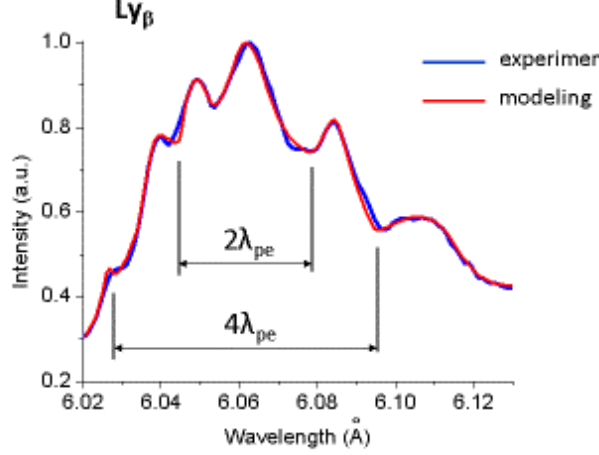
Figure 4. Experimental spectrum of Al XIII Ly β and its comparison with the Stark broadening code including L-dips and the spectral line broadening by LET. The experimental spectrum was obtained in a single laser shot with initial laser intensity at the surface of the target estimated as 6.7 × 10 20 W/cm 2 . The positions of the L-dips in the profiles (the L-dips being very pronounced) are marked by vertical lines separated either by 2 λ pe or 4 λ pe , where λ pe = [ λ 02 /(2 π c )] ω pe ( λ 0 is the unperturbed wavelength of the corresponding line). Also shown is a theoretical profile at N e = 2.35 × 10 22 cm − 3 allowing, in particular, for L-dips and for a low-frequency electrostatic turbulence. This value of Ne is much lower than Ne obtained from fitting the same experimental spectrum by code FLYCHK that did not include the L-dips phenomenon and the spectral line broadening by LET, and therefore had significant discrepancies with the experimental profile at the locations of the L-dips [12].